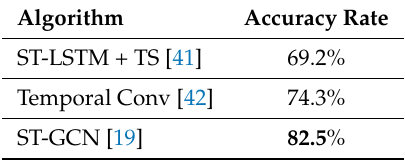
Figure 19. Hardware of our system.